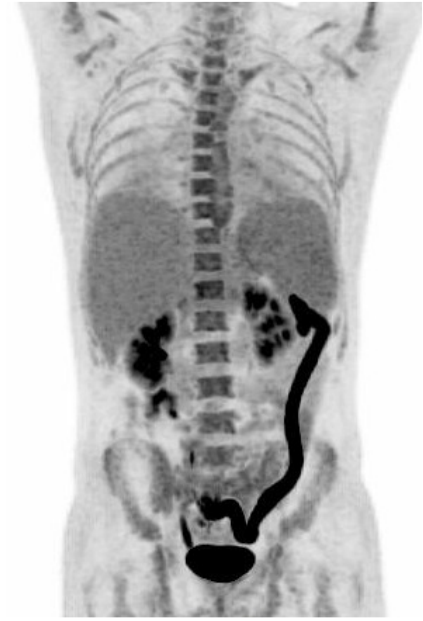
Figure 1. A 33 year-old man with known inflammatory bowel disease (IBD), on azathioprin (Imurel®) and mesalazin (Asacol®) treatment, presented with two weeks of hyperpyrexia up to 40.6 °C, dry cough, and water like diarrhoea which—unlike usual IBD—contained only a limited amount of blood. One month earlier, the patient had been travelling for 17 days in Jamaica. The patient was initially treated as an outpatient with roxithromycin for suspected pneumonia with no effect, and was Protein (CRP) 58 mg/L (normal range <10 mg/L), Alanine aminotransferase (ALAT) 217 U/L (normal